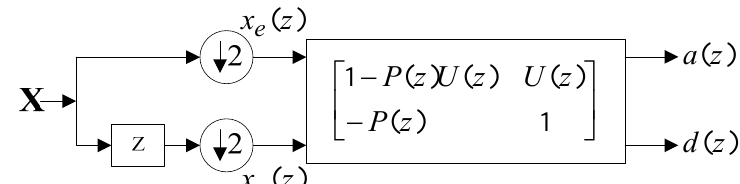
Figure 1. Expression of multi-phase matrix for lifting